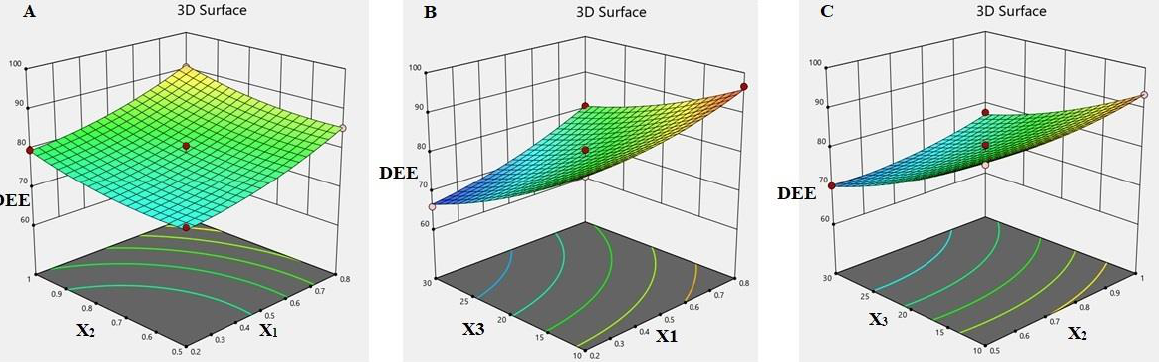
Figure 2. Three-dimensional-response surface plot showing effect of independent variables ( A ) X 1 and X 2 ; ( B ) X 1 and X 3 ; and ( C ) X 2 and X 3 on DEE.